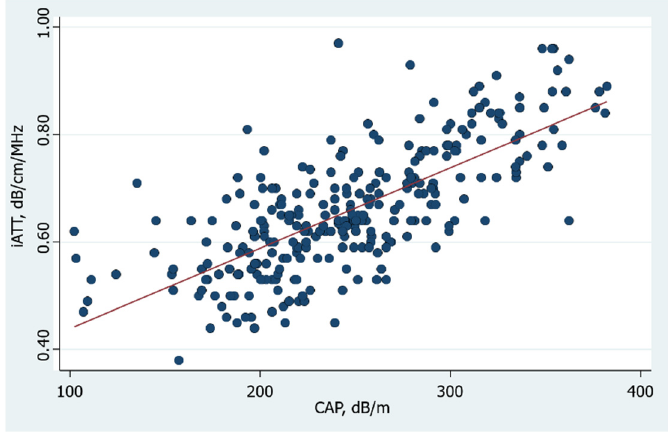
Figure 4. Graph of the overall correlation of iATT with CAP. The correlation was affected by the IQR/M of the 10 measurements: it was r = 0.75 ( p = 10 − 5 ) in the 203 cases showing an IQR/M of the iATT value ≤ 15%, and the correlation was the same ( r = 0.75, p = 10 − 5 ) in the 130 cases with an IQR/M ≤ 10%, whereas it was r = 0.60 ( p = 10 − 5 ) in the 77 cases with an IQR/M > 15% (Table 2). Table 2. Concordance between ATT and CAP values.